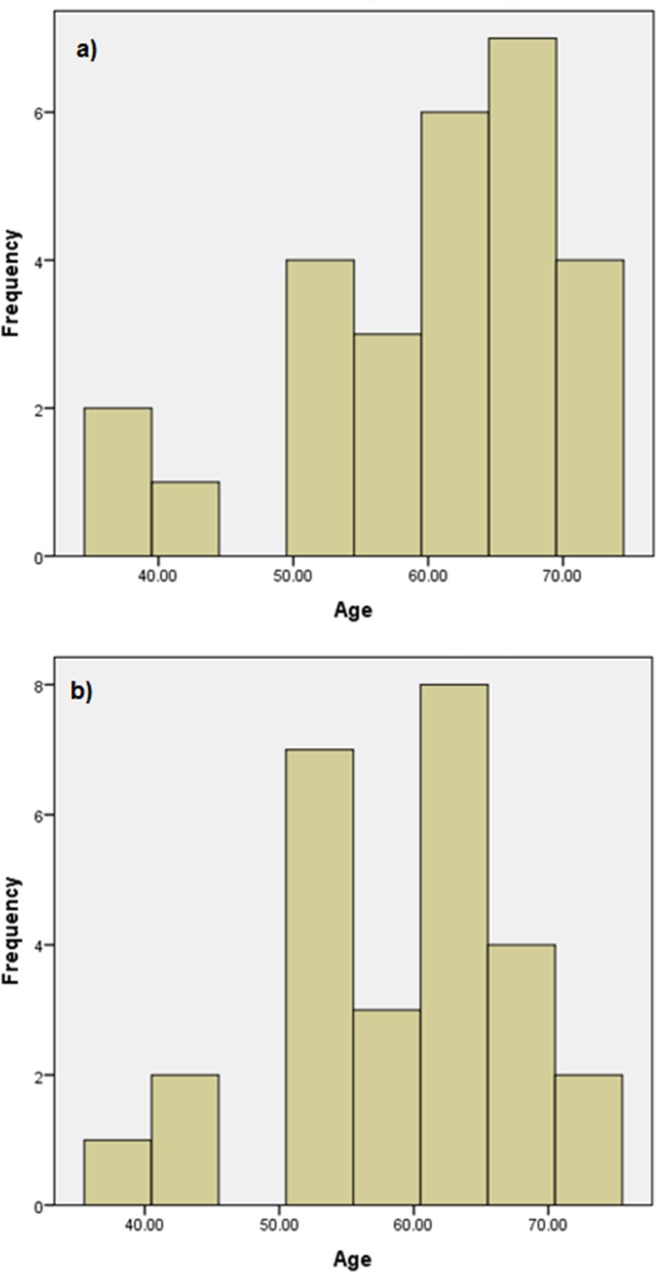
Frequency histogram of age distribution.The age distribution is shown for a) test subjects (with glaucoma and cataract: mean 60 years, SD 10.22 years) and b) controls (cataract only: mean 59 years, SD 9 years). Each cohort comprised 27 subjects.